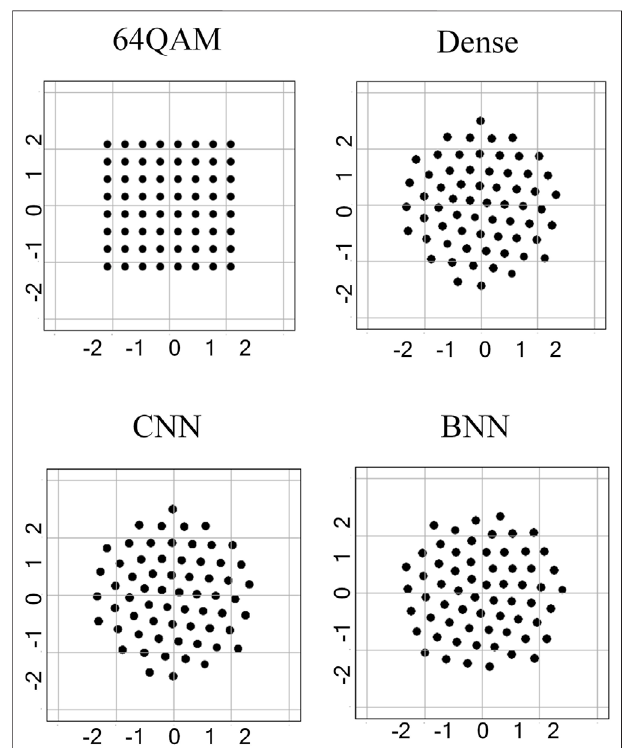
FIGURE 5 | Learned constellation maps when transmitting